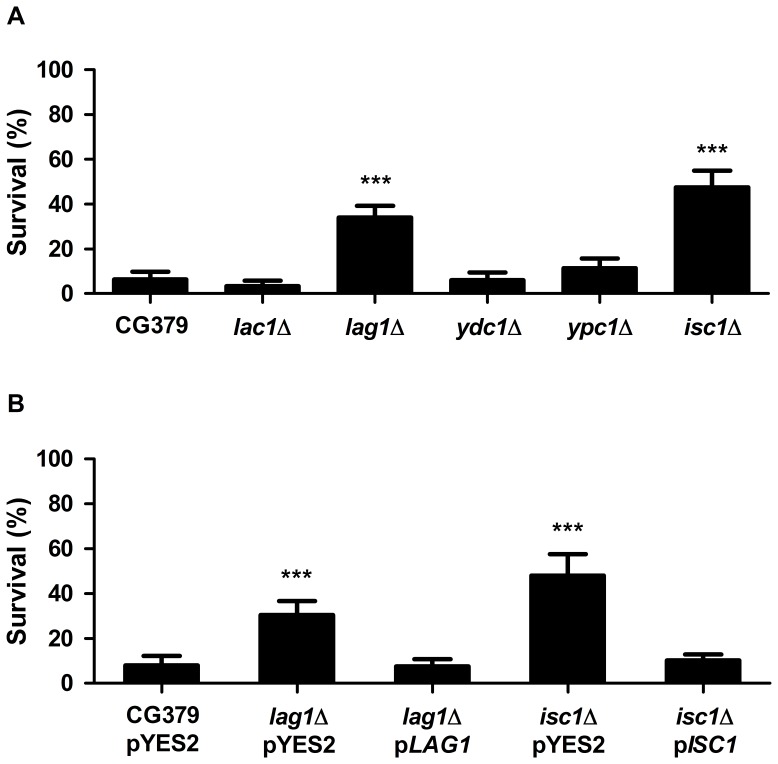
Acetic acid resistance in S. cerevisiae.(A) CG379 (wild-type), lac1Δ, lag1Δ, ydc1Δ, ypc1Δ and isc1Δ strains, or (B) CG379 pYES2 (empty vector), lag1Δ transformed with pYES2 or pLAG1, and isc1Δ transformed with pYES2 or pISC1. Cells were exposed to 180 mM acetic acid, pH 3.0, for 200 min. Cell viability was determined by standard dilution plate counts and expressed as a percentage of c.f.u on YPD plates. Values are mean ± SD of at least three independent experiments. Values significantly different from CG379 strain: *** P<0.001, One-way ANOVA and Tukey Test.